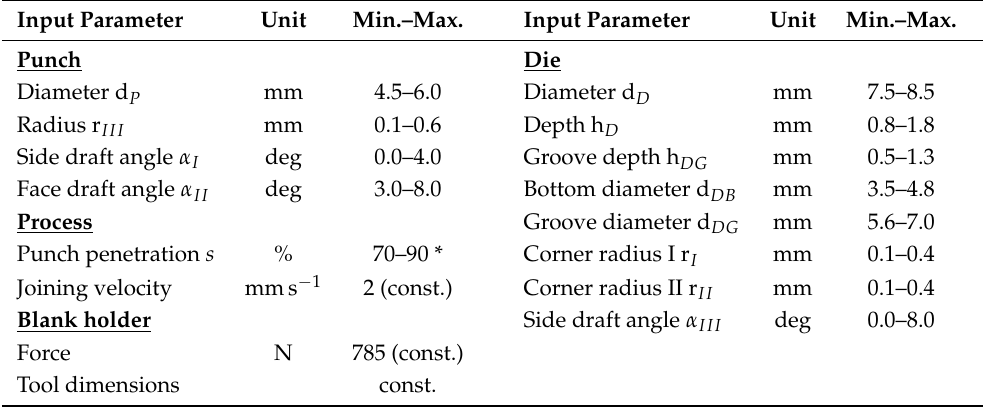
Table 1. Input parameters and the relating minimum/maximum